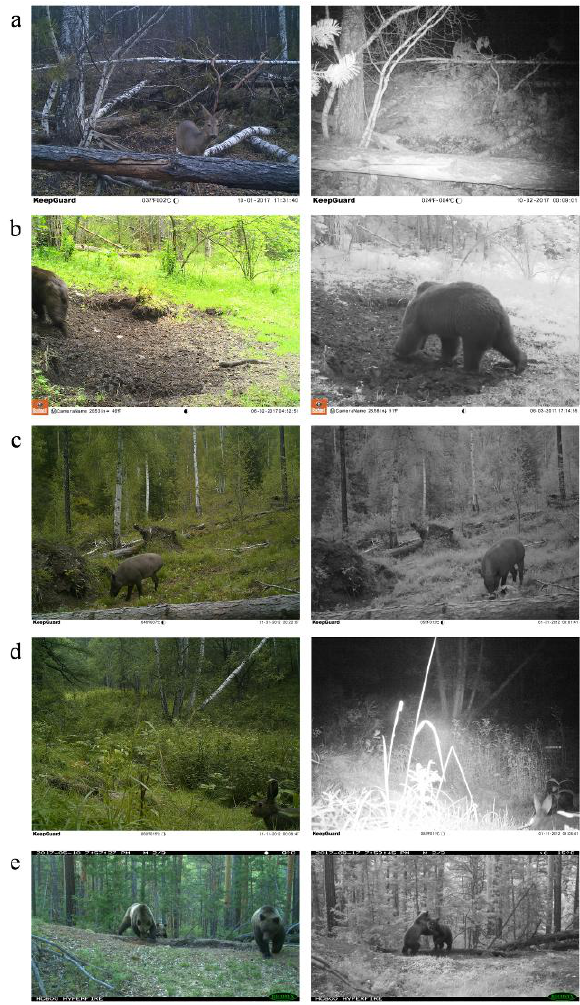
Figure 7. Examples of experimental images captured by different camera traps at day and night